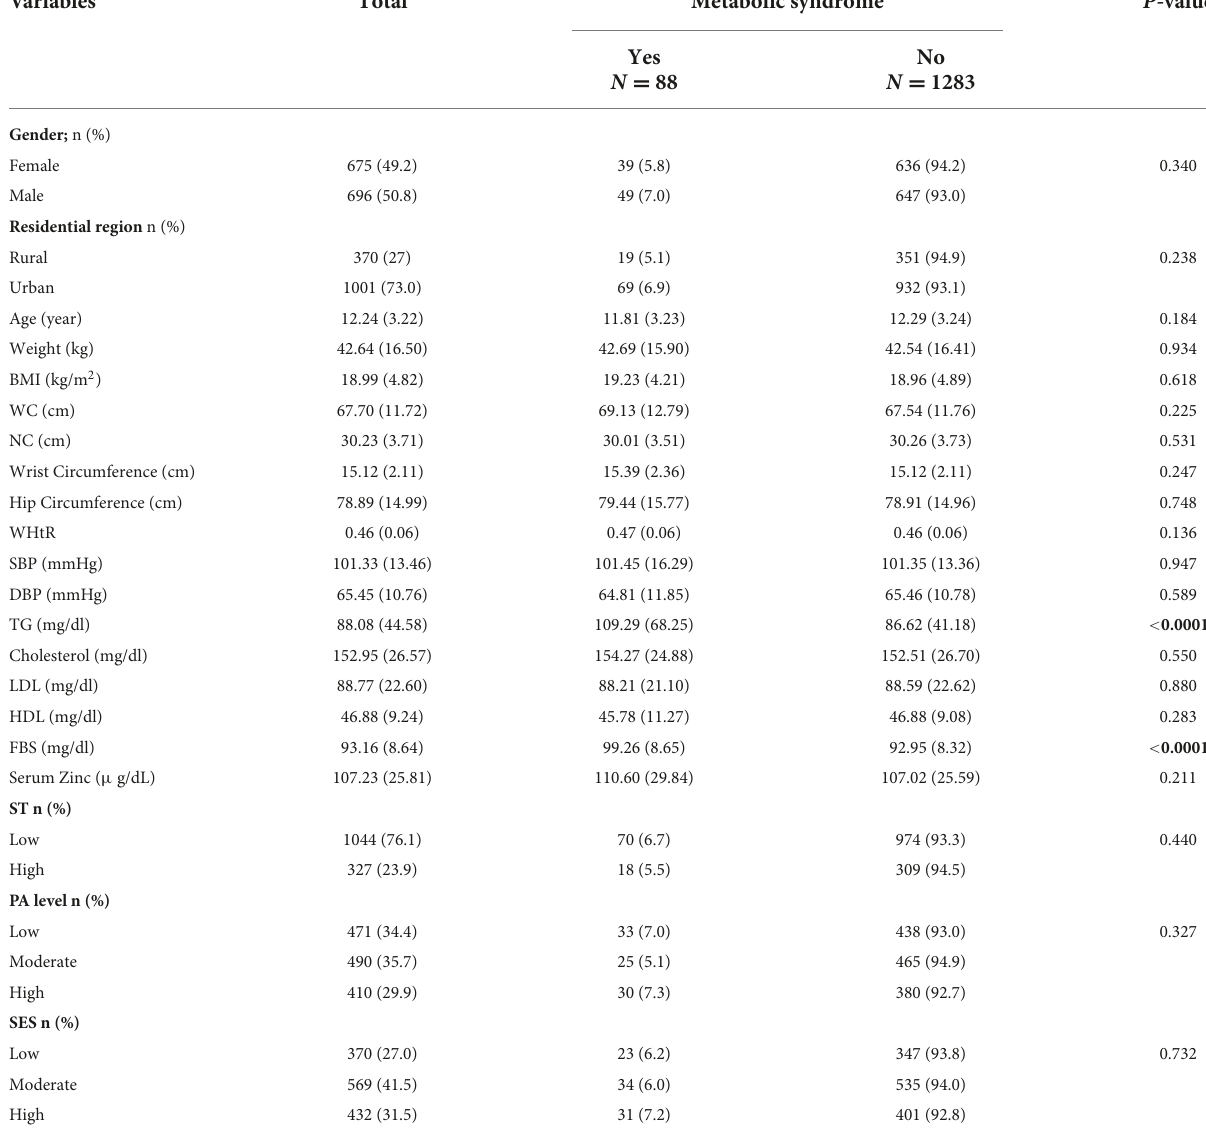
TABLE 1 Demographic status of the study population according to the presence or absence of metabolic syndrome ( n = 1371).